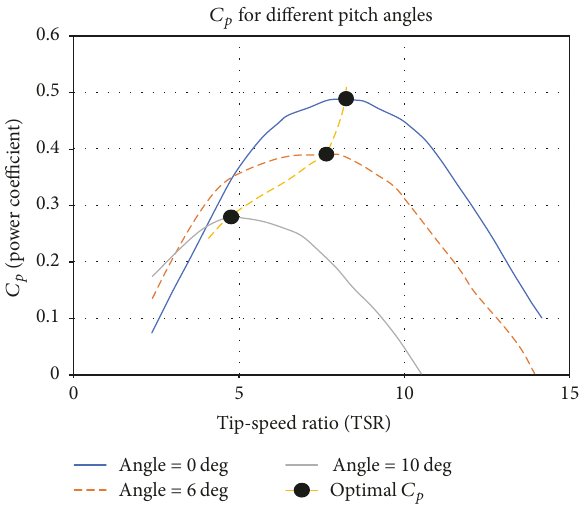
Figure 1: Power coefficient versus tip speed ratio